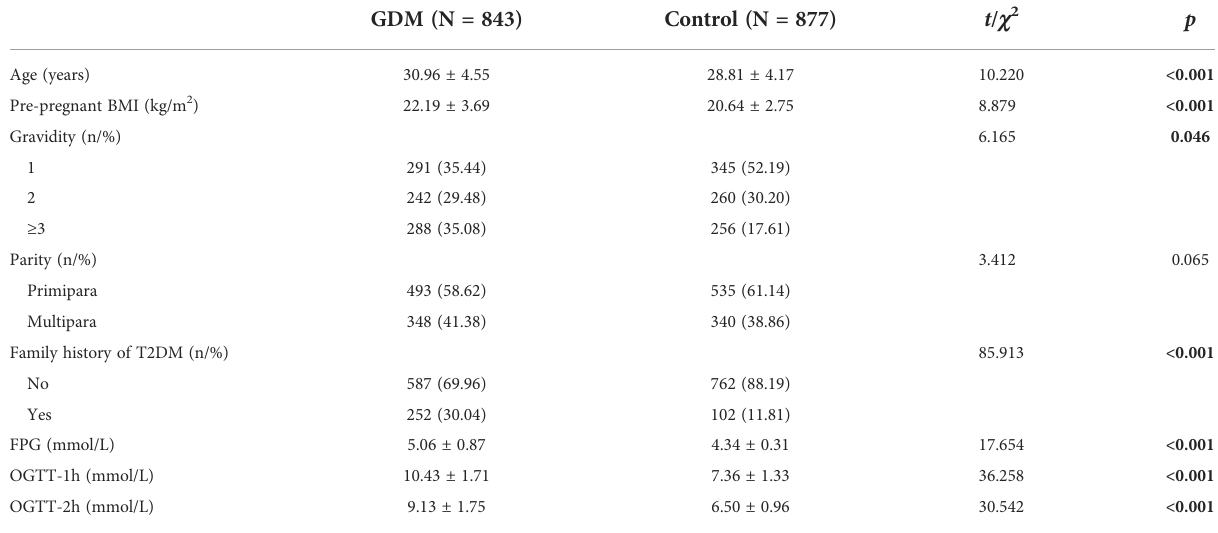
TABLE 1 The basic characteristics of the